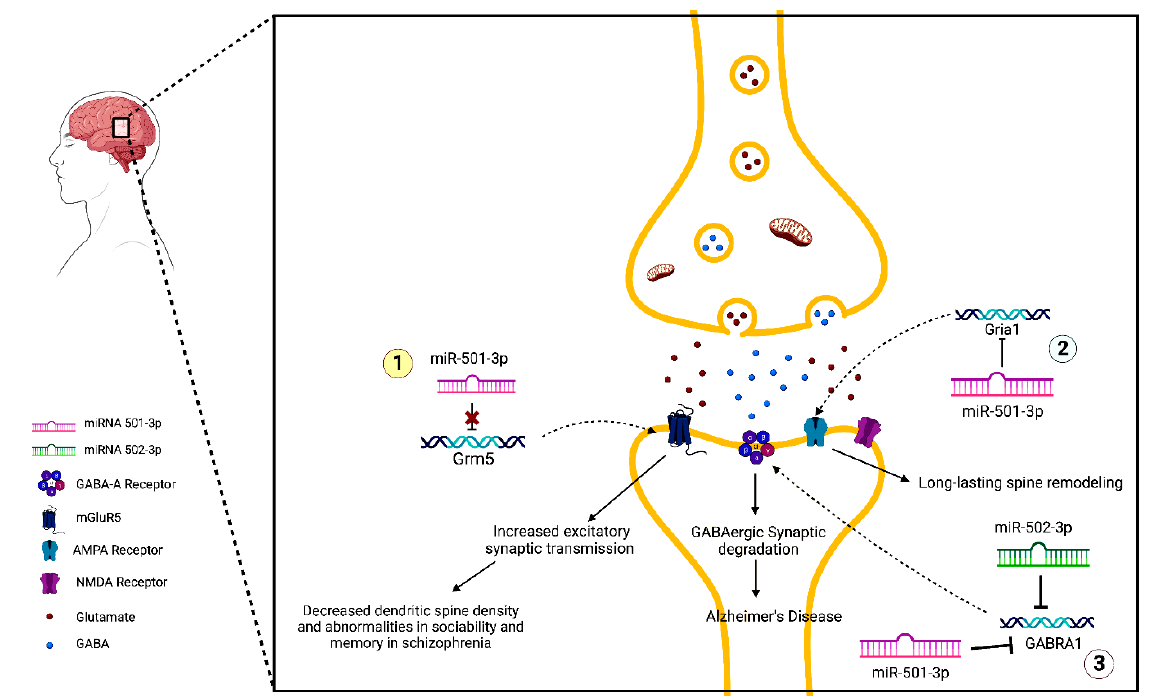
Figure 4. MiR-502-3p- and miR-501-3p-mediated molecular mechanisms of synaptic dysfunction in AD. (1) MiRNA-501-3p binds to the 3′UTR of Grm5 and inhibits its expression. In schizophrenia, miRNA-501-3p is downregulated, causing increased expression of Grm5 and mGluR5, the receptor for which it codes. This leads to increased excitatory synaptic transmission, which eventually results in the loss of total dendritic spine density and abnormalities in sociability and memory. (2) NDMAR- mediated changes in AMPAR expression occur via a miRNA-501-3p pathway. MiRNA-501-3p binds to the 3′UTR of Gria1 and inhibits its expression. This causes decreased production of the GluA1 subunit of AMPARs. This process is responsible for long-lasting spine remodeling. (3) Both miRNA- 501-3p and miRNA-502-3p negatively modulate GABRA1 expression, leading to a decrease in GABA-A receptors. This may be a potential mechanism for the synaptic degradation of GABAergic synapses that lead to AD.